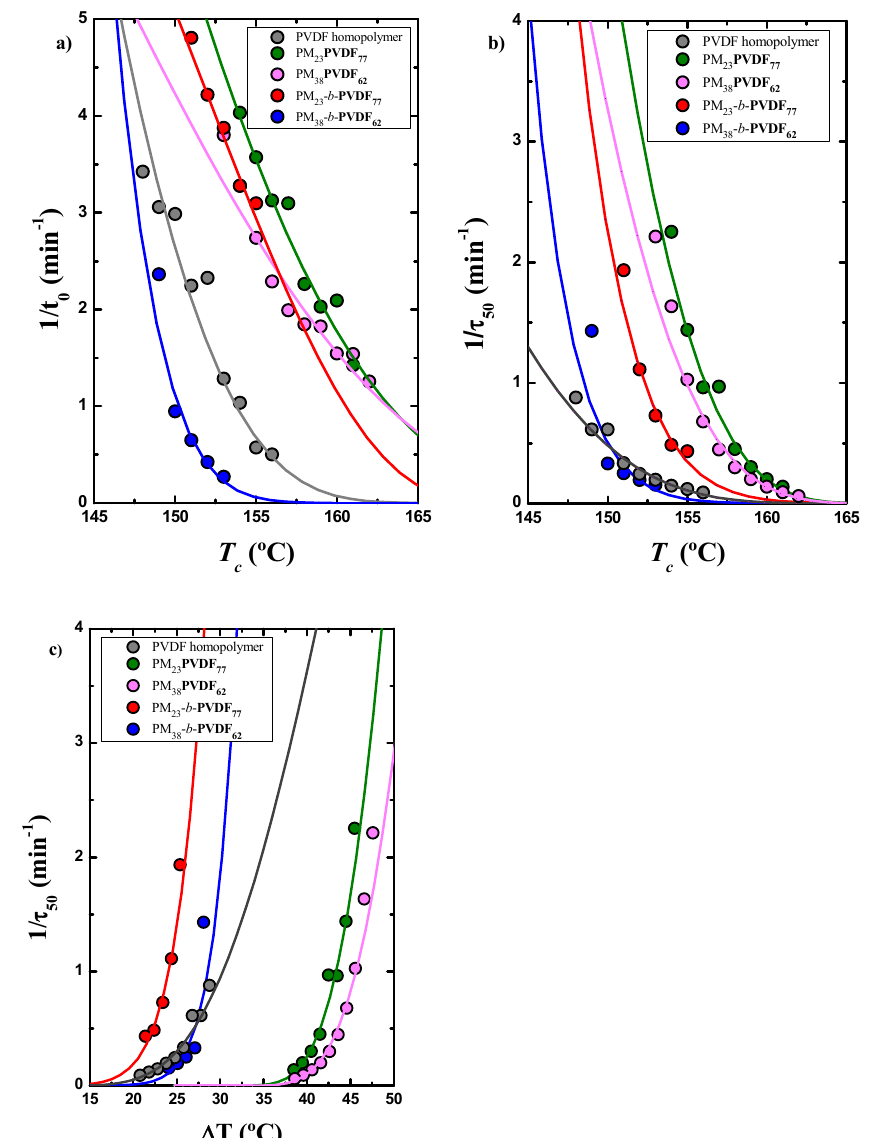
Figure 10. ( a ) 1/t 0 as a function of crystallization temperature and inverse of half-crystallization time for the PVDF component of all samples shown as a function of ( b ) T c and ( c ) ∆ T for all the PVDF samples measured by DSC. The solid lines are the fits to the Lauritzen–Hoffman (LH) theory.